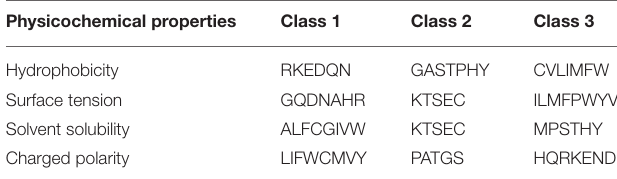
TABLE 1 | Classification of amino acids based on different types of physicochemical